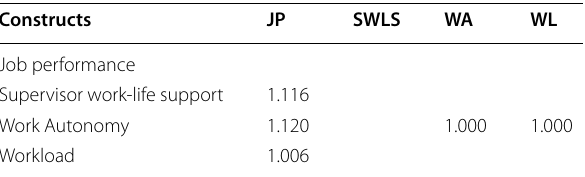
Table 4 VIF (Inner values)